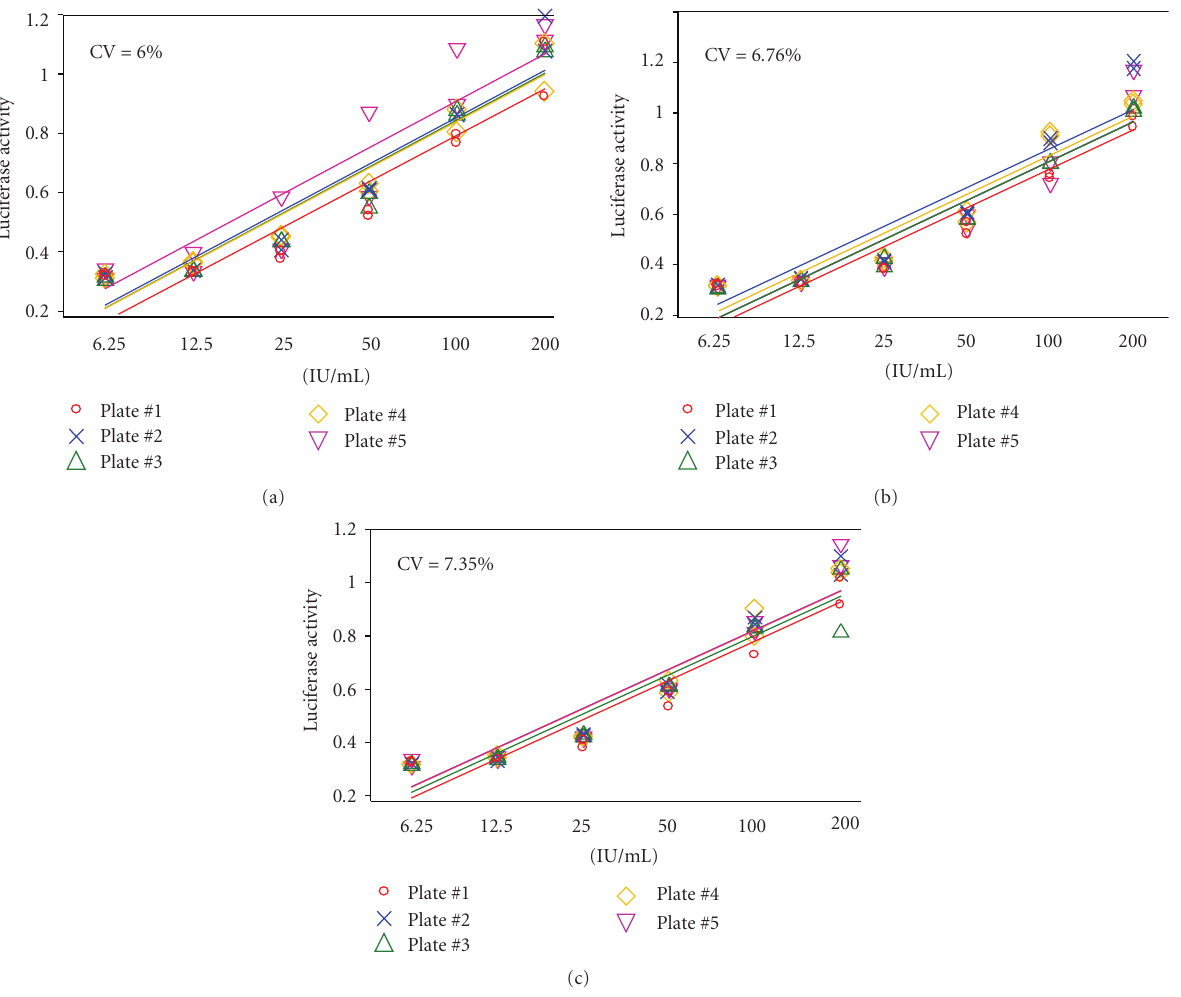
Figure 2: Intra-assay variation. Three samples were used. Sample 1 was the In-House reference standard (a), with sample #2 and #3 being final products reconstituted from final drug products in syringes (b, c). Each dose was run in triplicate and tested on 5 di ff erent plates. The graphs depict the linear range of the tested doses as determined by comparison to the NIH IFN- β